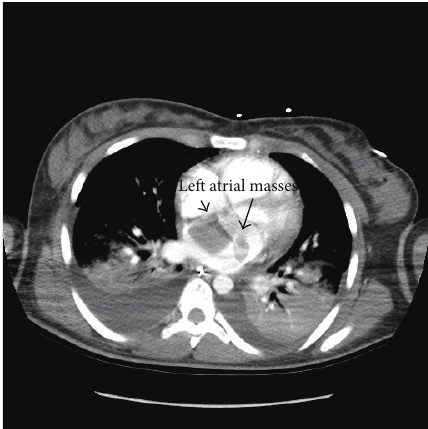
Figure 2: CT of the chest following intravenous contrast showing left atrial mass.